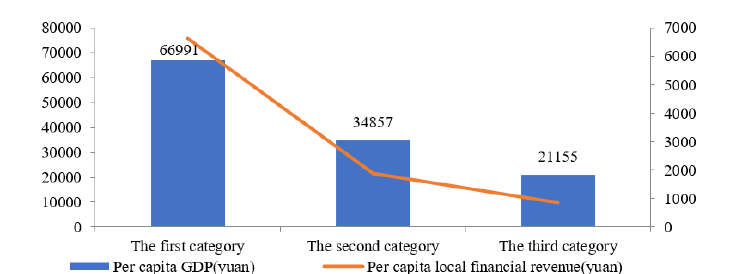
Fig. 3 A comparison of the scale of per capita county economies relating to the three